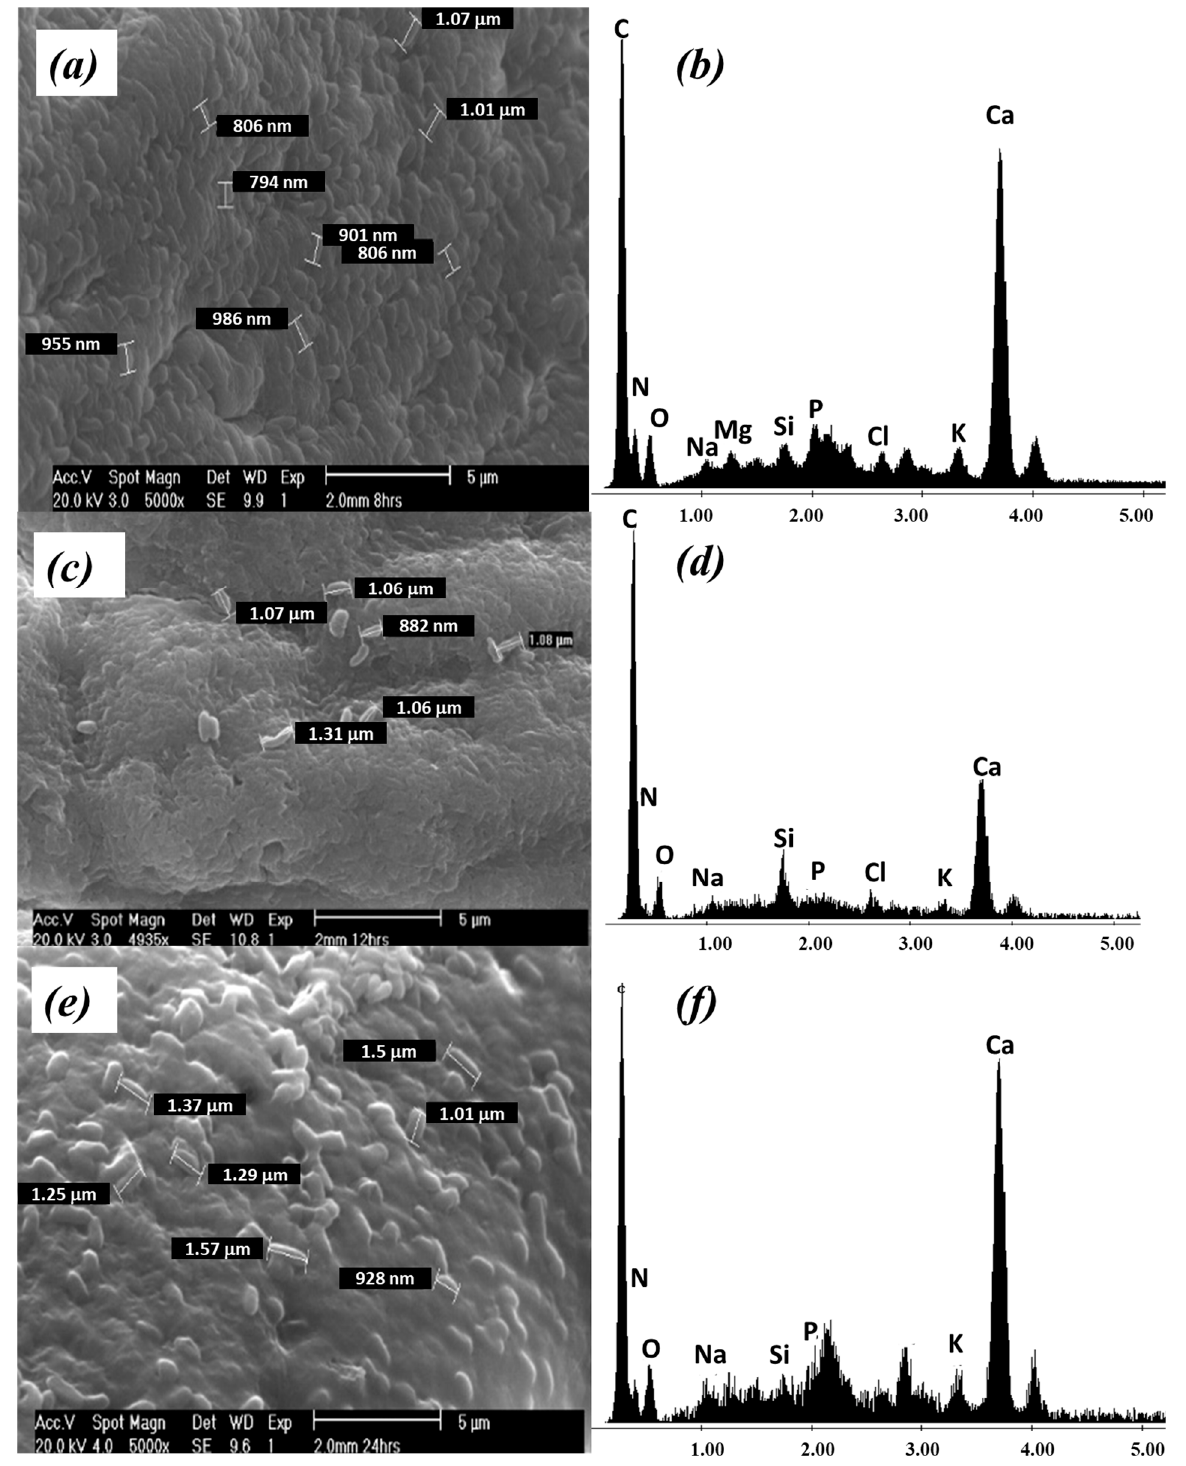
Figure 2. P. koreensis supported on alginate beads at different time: ( a ) MEB and ( b ) EDS at 8 h; ( c ) MEB and ( d ) EDS at 12 h; ( e ) MEB and ( f ) EDS at 24 h.